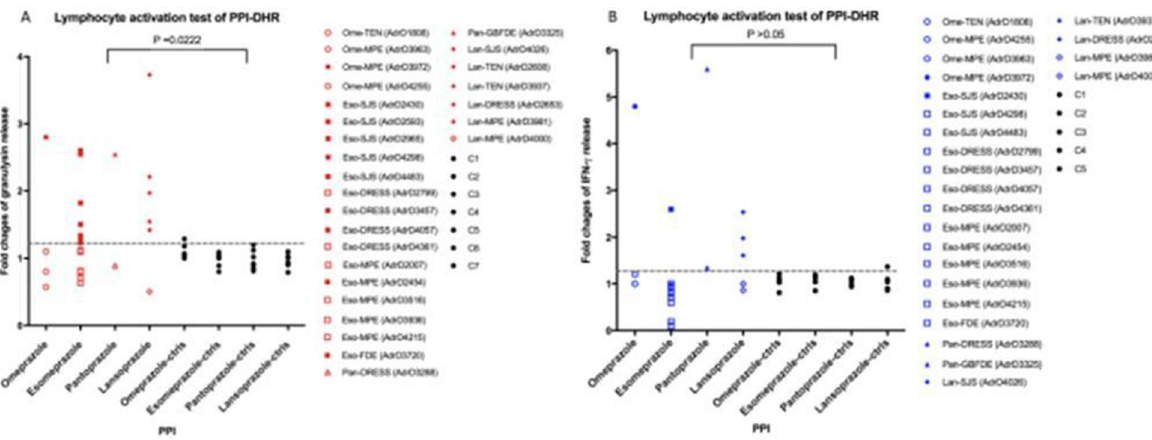
Table 1 Allergological investigation by lymphocyte activation text of PPI‑related